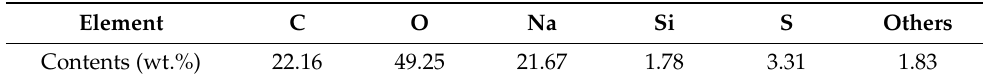
Figure 1. Macrograph and micrograph of SAP. Table 2. The element content of SAP.